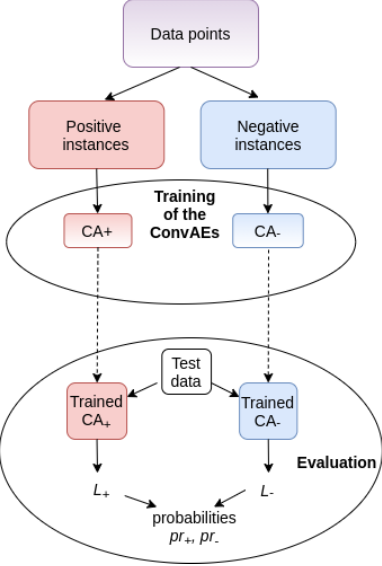
Figure 1. Overview of AutoNowP